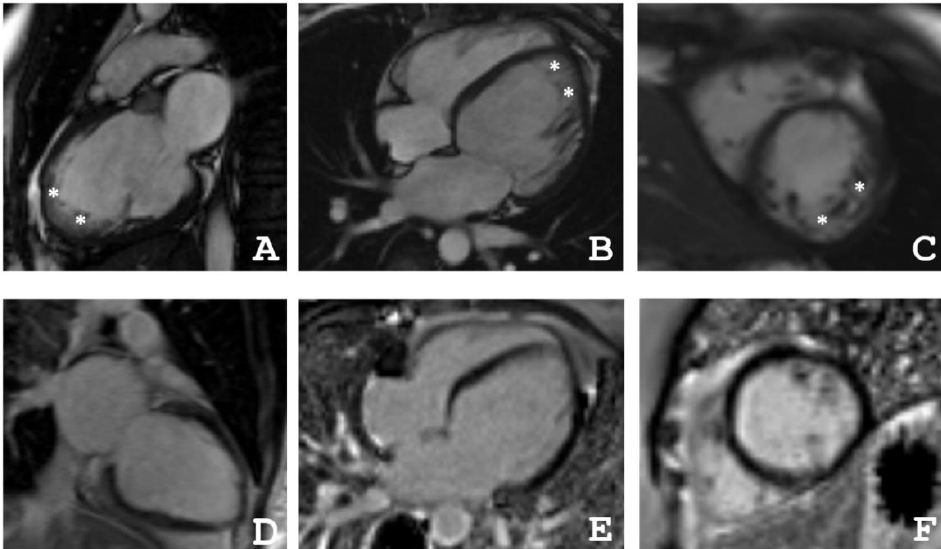
Figure 2. ( A – C ) Proband’s (III-4) cardiac magnetic resonance imaging in movie mode, steady-state free-precession (SSFP) sequence: ( A ) long axis 2–chamber projection, ( B ) long axis 4–chamber projection, ( C ) short axis at the level of the apical segments, * indicates a layer of non-compacted myocardium, ( D – F ) delayed contrast. Inversion recovery sequence with suppression of the signal from the myocardium. No areas of contrast, which indicates the absence of areas of intramyocardial fibrosis, scarring, and inflammatory myocardial